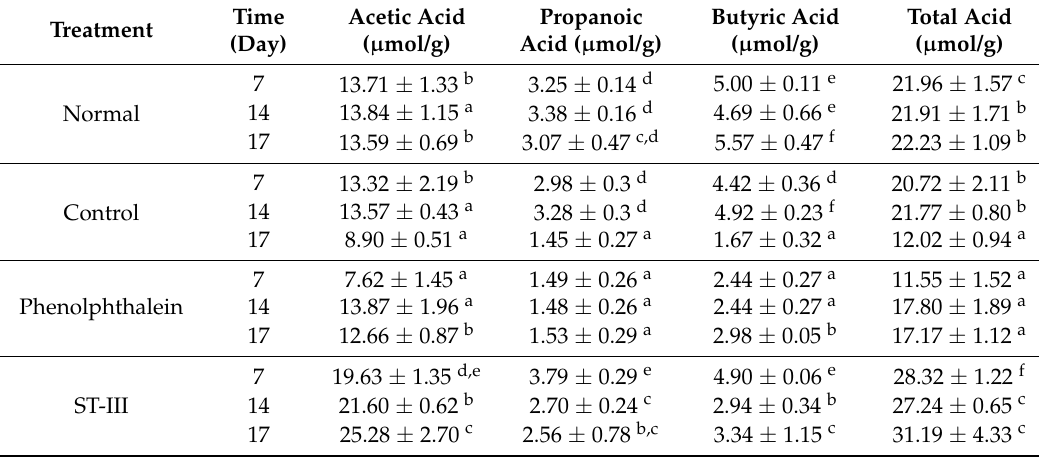
Table 3. Short-chain fatty acids (SCFAs) in feces.